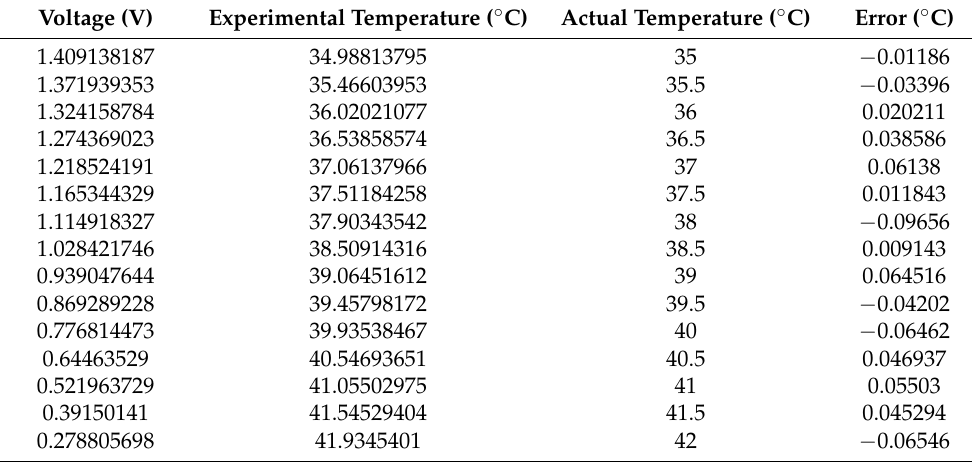
Table 3. Experimental results of temperature measurement in AWG interrogation